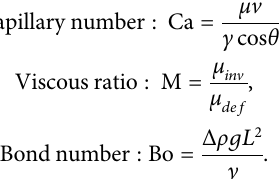
Frontiers in Mechanical Engineering |